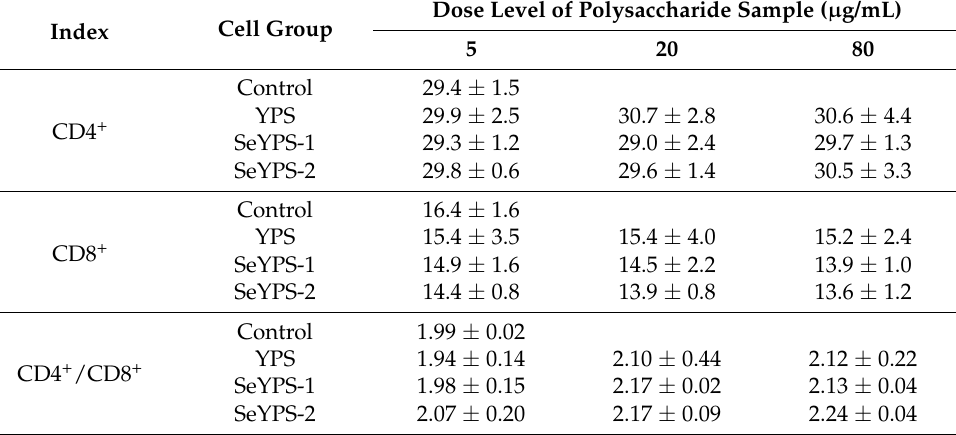
Figure 5. The analyzed results for T-lymphocyte subpopulations by flow cytometry for the control splenocytes ( a ), or those treated by YPS ( b – d ), SeYPS-1 ( e – g ), and SeYPS-2 ( h – j ) at different dosages. Table 1. The measured T-lymphocyte sub-populations (%) in the Con A-stimulated splenocytes as affected by YPS, SeYPS-1, and SeYPS-2 at 5, 20, and 80 µ g/mL for 48